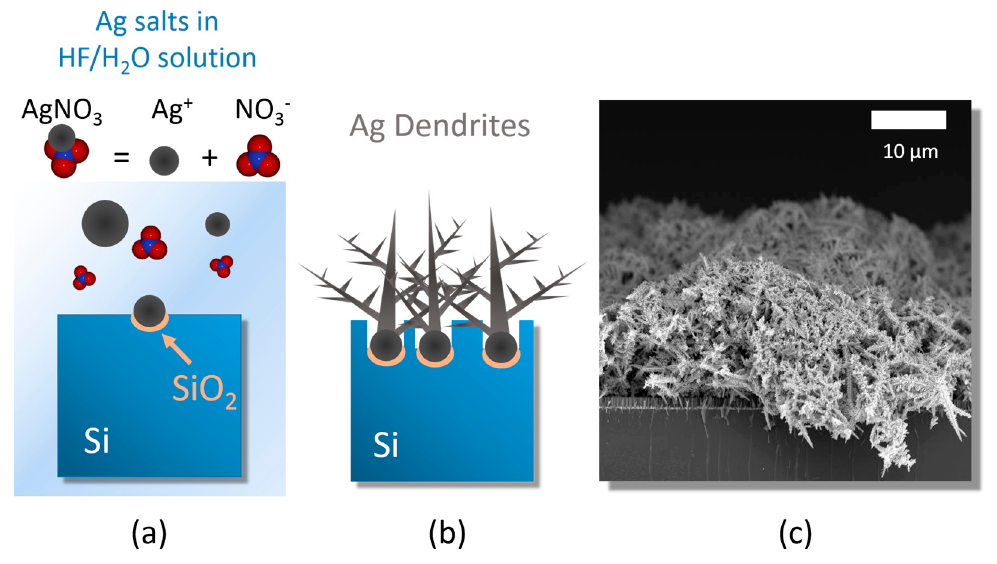
Figure 1. Ag dendrite synthesis. Schematic depicting the growth of Ag dendrites from ( a ) the dissolution of AgNO 3 salts in a HF / H 2 O solvent, leading to the formation of Ag nanoparticles that subsequently precipitate onto the Si bulk. ( b ) Ag dendrites were developed by further incorporating the Ag + ions onto the initial seeds. ( c ) Cross-section SEM microscopy of the produced carpet of Ag dendrites onto the Si bulk.